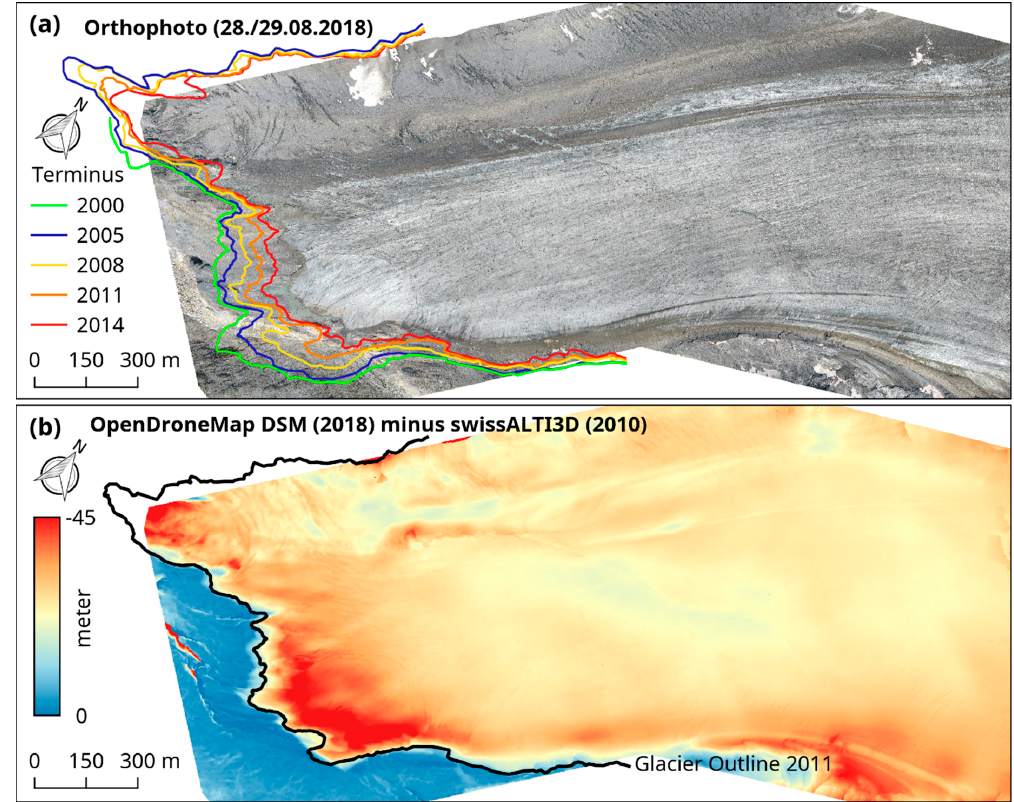
Figure 11. ( a ) High-resolution (5 cm) OpenDroneMap orthophoto of the Kanderfirn from 28–29 August 2018 based on 850 aerial images. Five orthomosaics of the Swiss Federal Office of Topography from 2000, 2005, 2008, 2011 and 2014 served for mapping changes of the terminus. ( b ) Glacier surface elevation change (in meters) between 2010 and 2018 based on the difference of two DSMs (OpenDroneMap DSM 2018 minus swissALTI3D 2010).